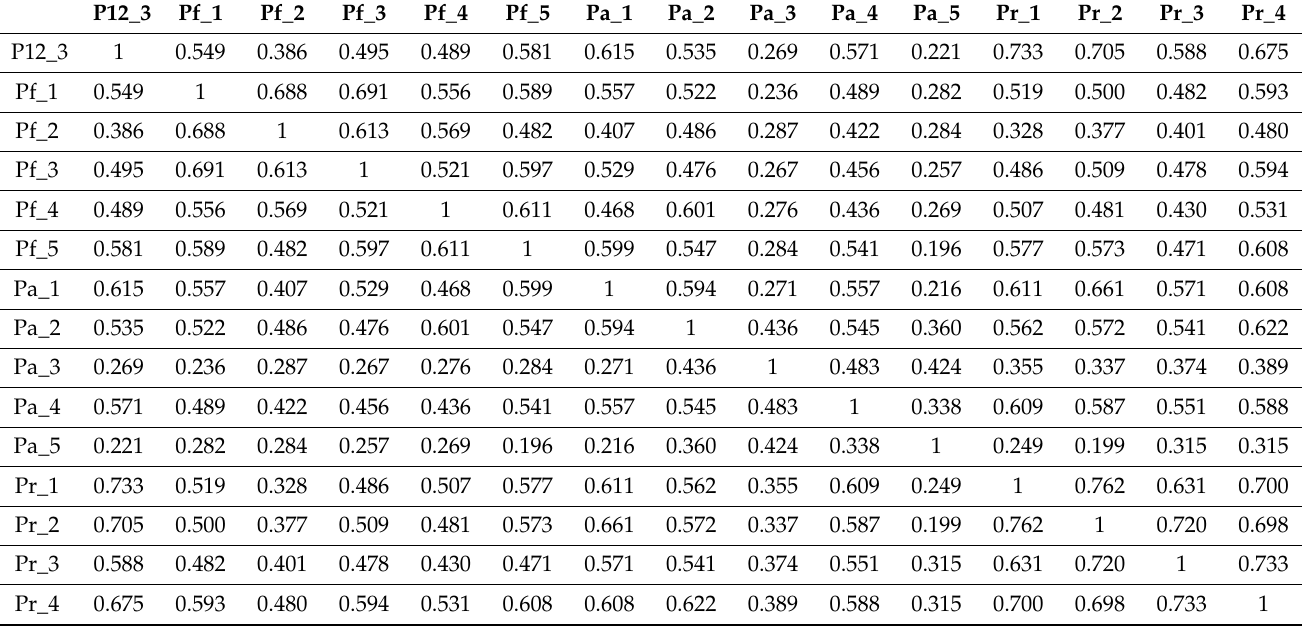
Table 2. Correlation analysis between